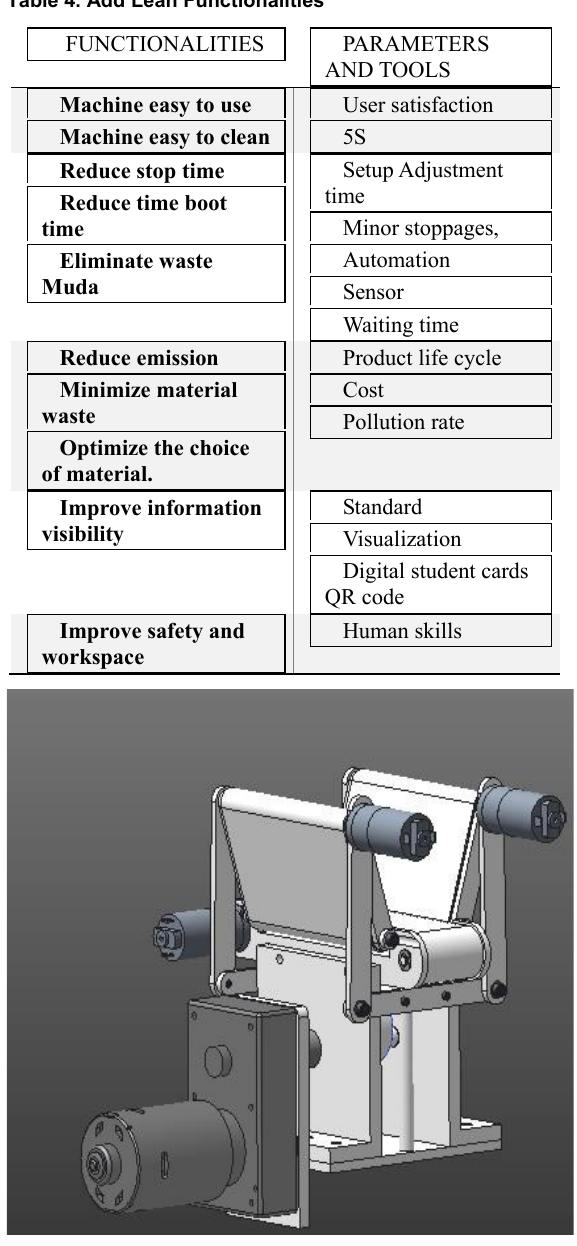
Figure 9. Sorting system